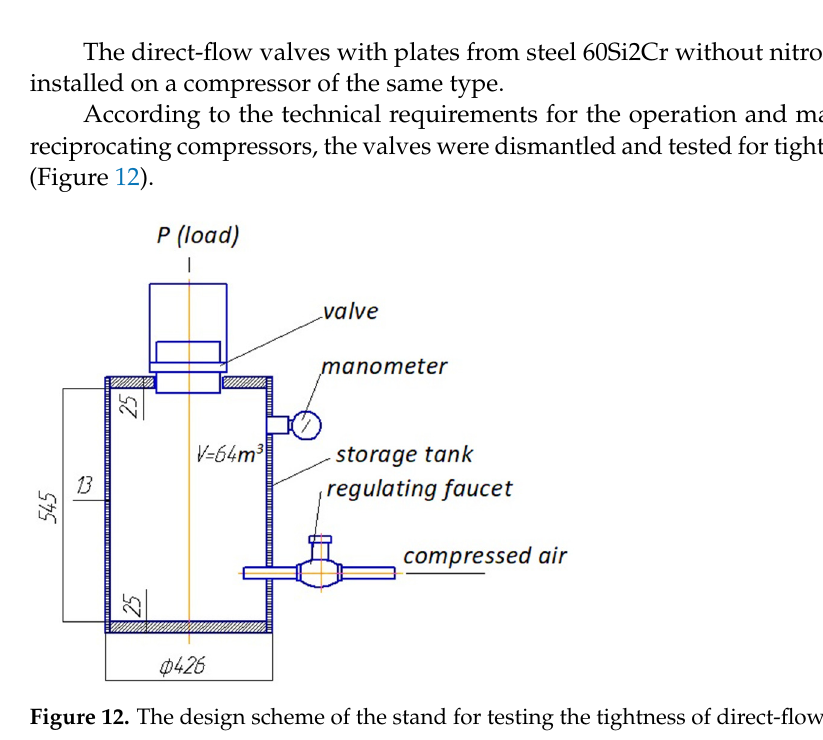
Figure 12. The design scheme of the stand for testing the tightness of direct-flow valves.